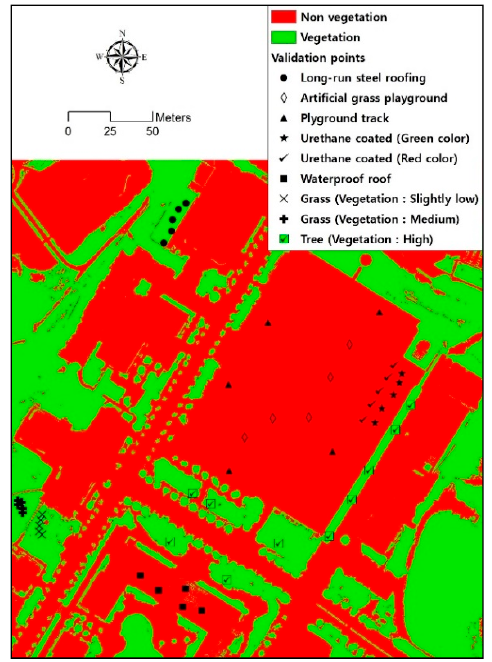
Figure 12. Vegetation map and validation points based on the squared Red-Green NDVI index.